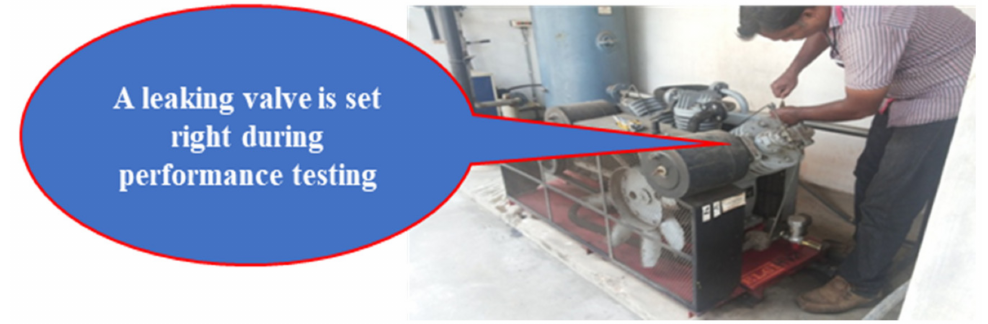
Figure 6. Leakage valve maintenance during